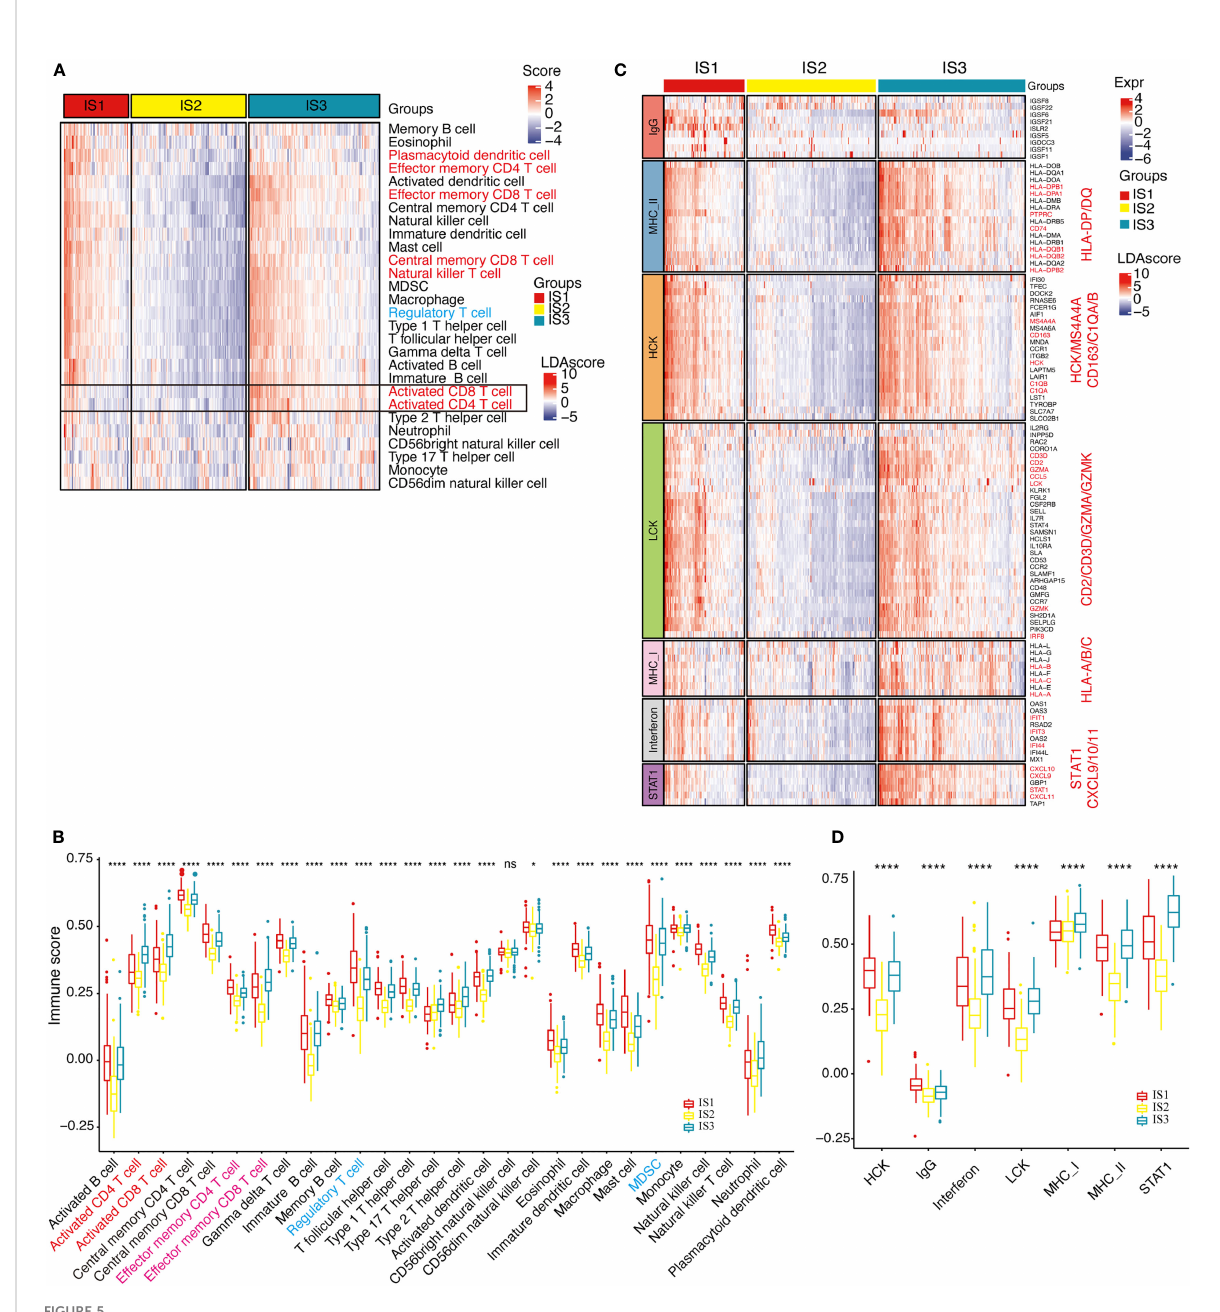
FIGURE 5 Distribution of immune cell characteristics and in fl ammation characteristics among ISs. (A, B) . Heat map (A) or boxplot (B) show the differential enrichment scores of 28 immune cell signatures among immune subtypes in TCGA -COAD cohorts. Activated CD4T, CD8T cells (highlighted with orange) are predominantly in fi ltrated in the IS3 subtype, while regulated T cells and MDSC cells (both are immunosuppressive cells, highlighted in blue) are predominantly in fi ltrated in the IS1 subtype. The top and bottom of the box are the upper quartile (Q3) and the lower quartile (Q1) of the data, respectively. The solid line in the box represents the median. The whiskers represent the maximum and minimum values of this group of data. The Kruskal – Wallis test was used to assess for signi fi cant differences. n.s, not signi fi cant, * P < 0.01, ** P < 0.001, *** P < 0.0001, and **** P < 0.00001. (C) . Heat map for the expression level of in fl ammation-related genes in each patient among immune subtypes in TCGA -COAD cohorts. Marker genes are highlighted in orange. (D) . Differential enrichment scores of all seven in fl ammation-related metagenes among immune subtypes in TCGA -COAD cohorts. The IS3 subtype has the highest enrichment scores with LCK, MHC-I, MHC-II , and STAT1 gene clusters. The top and bottom of the box are the upper quartile (Q3) and the lower quartile (Q1) of the data, respectively. The solid line in the box represents the median. The whiskers represent the maximum and minimum values of this group of data. The Kruskal – Wallis test was used to assess for signi fi cant differences. ns, not signi fi cant, * P < 0.01 and **** P <